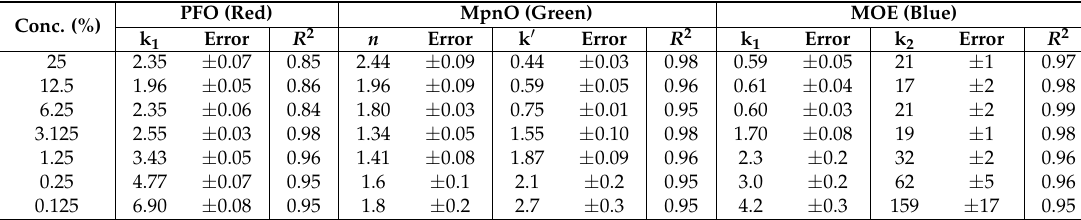
Table 6. Parameters and characteristics of experimental data fitted at different ammonia concentrations for the studied kinetic models (temperature at 25 ◦ C). Conc.